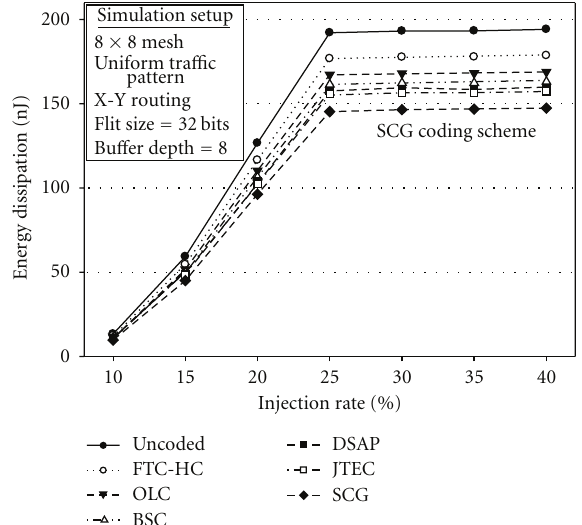
Figure 18: Energy dissipation of an 8 × 8 mesh-NoC with di ff erent joint CAC and ECC coding